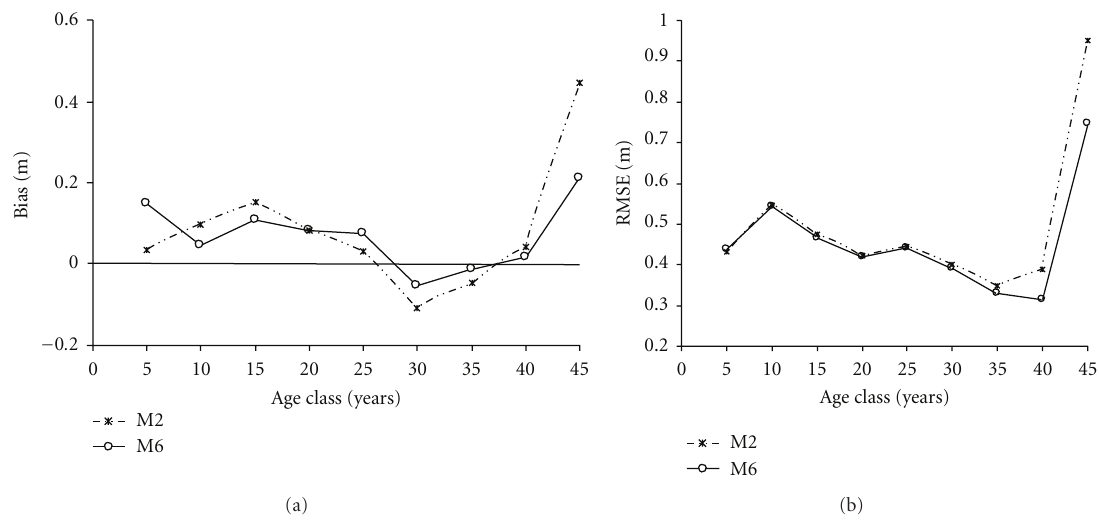
Figure 4: Bias and root mean square error (RMSE) in height estimation for models M2 and M6 by 5-year age classes.